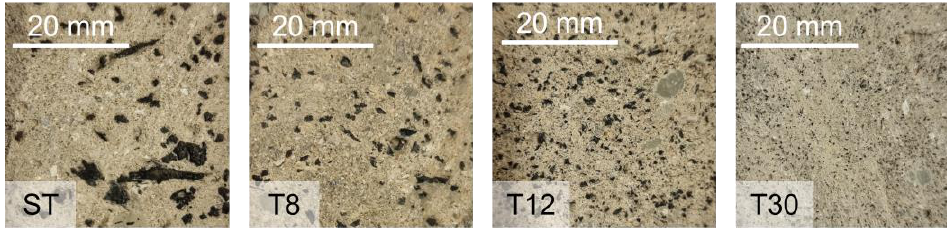
Figure 2. Cross-section of representative mortar samples with rubber shreds (ST) and crumbs at different particle sizes (T8, T12 and T30).